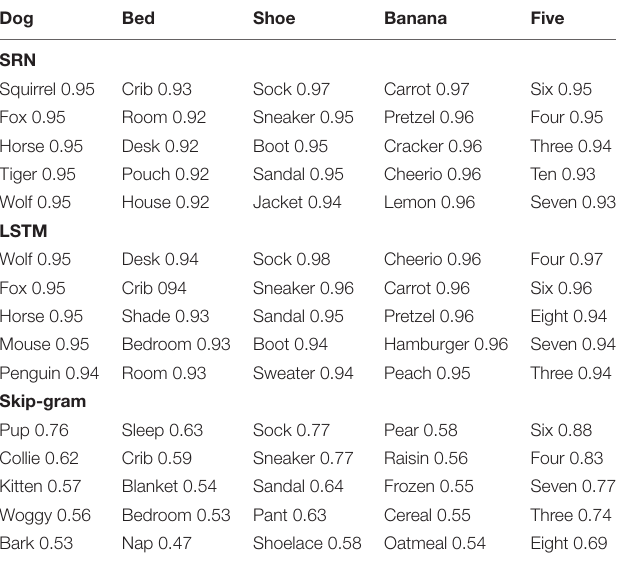
TABLE 3 | Nearest semantic neighbors after training for 1 of the 10 models for selected words, in terms of the average hidden activation state of the network (for SRNs and LSTMs) and in terms of the weight matrix (for